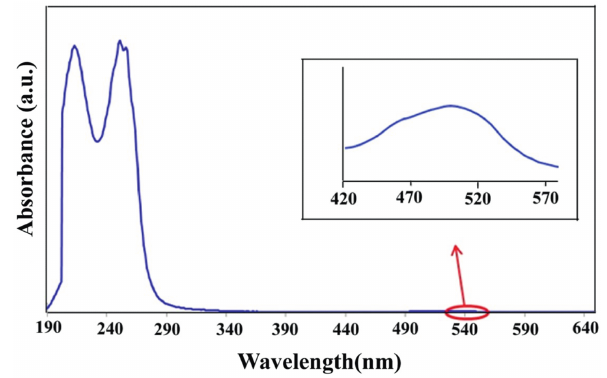
Figure 4: Electronic spectrum of [Co(py) 2 (H 2 O) 2 (NO 3 ) 2 ] (1 × 10 − 4 M) in